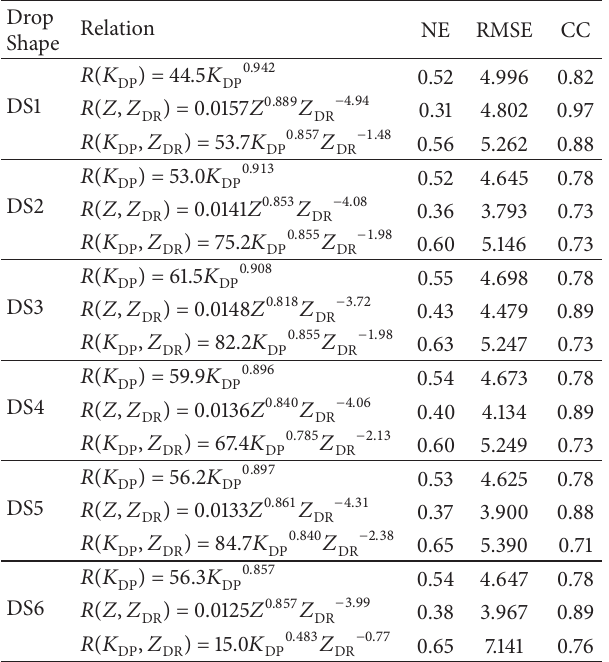
Table 4: The rainfall relations, NE, RMSE, and CC of each raindrop axis ratio relation. Drop Shape